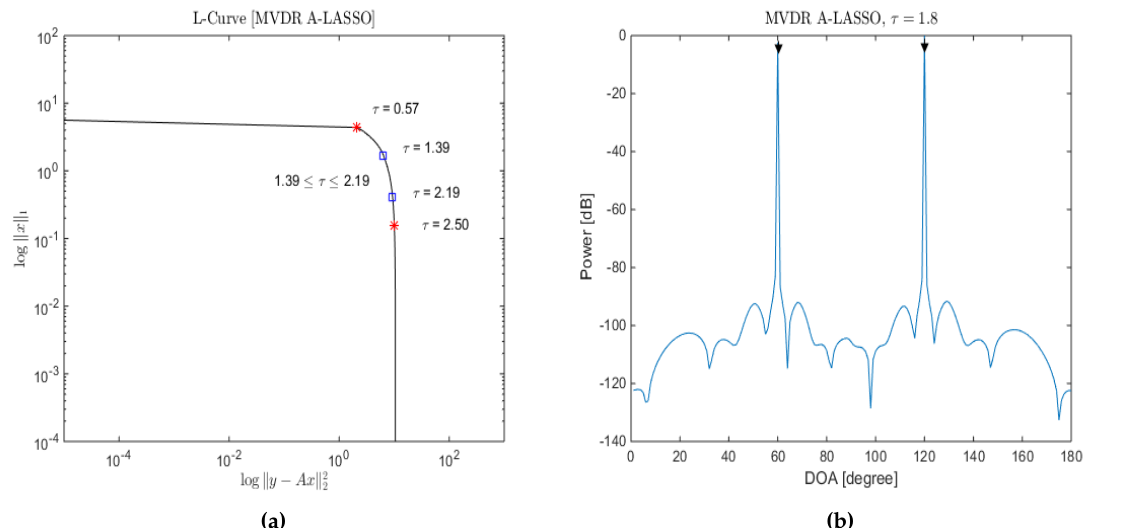
Figure 2. ( a ) The data residual (cid:107) y − Φ ∗ ¯ s (cid:107) 2 versus the solution (cid:96) 1 -norm linear scale on a log-log scale 2 (L-curve); ( b ) DOA estimation for two source signals; τ was selected using L-curve, in the MVDR A-LASSO problem (SNR = 10 dB).